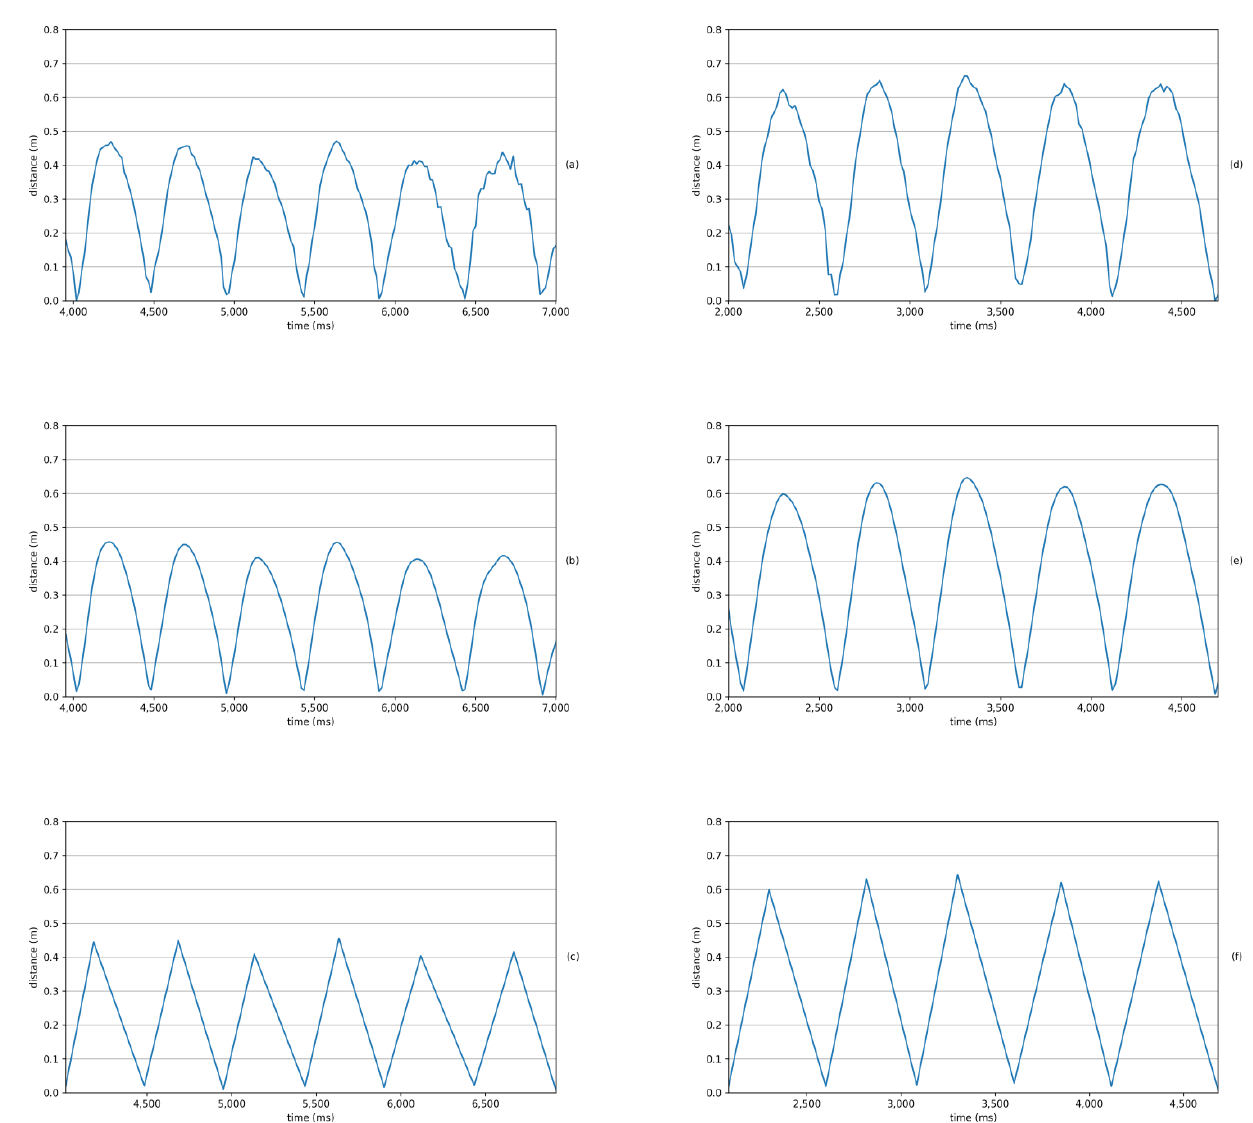
Figure 8. Plot of distance between heels for two paired subjects: ( a ) patient subject heels distance;